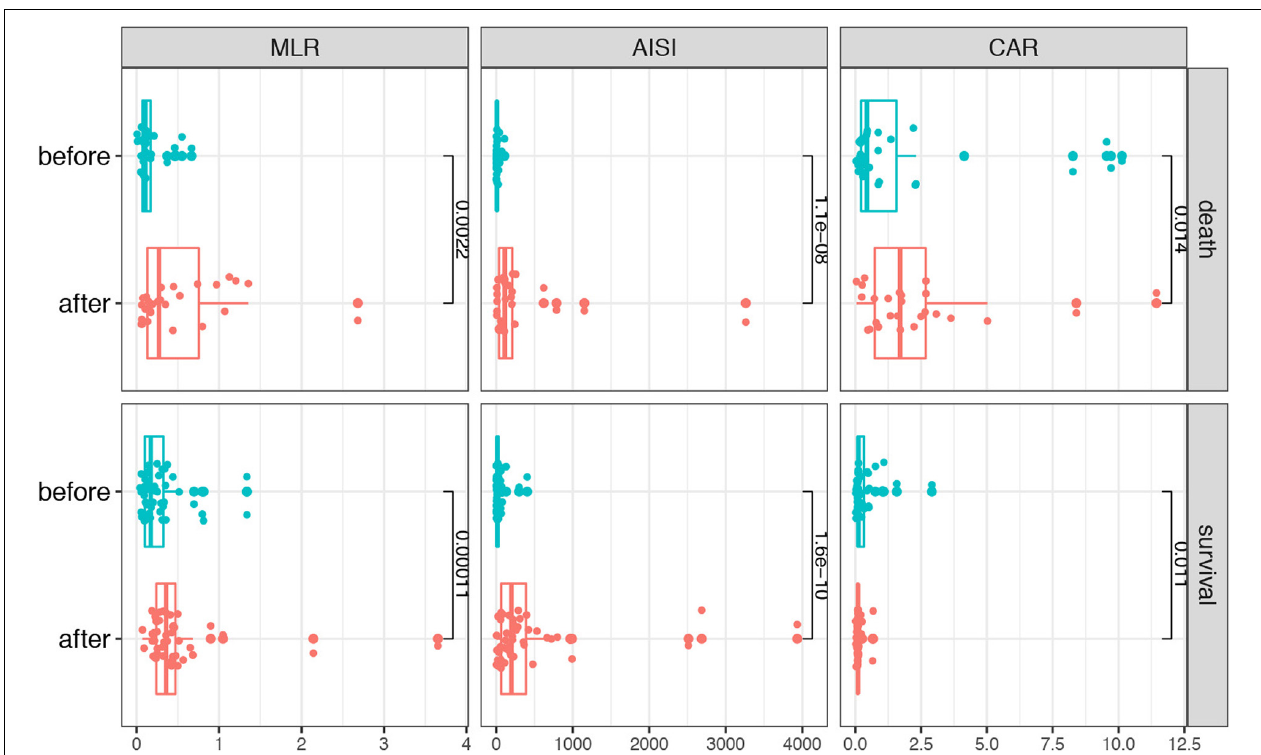
FIGURE 4 | The dynamic changes of the combined biomarkers before and after treatments in the SFTS patients.